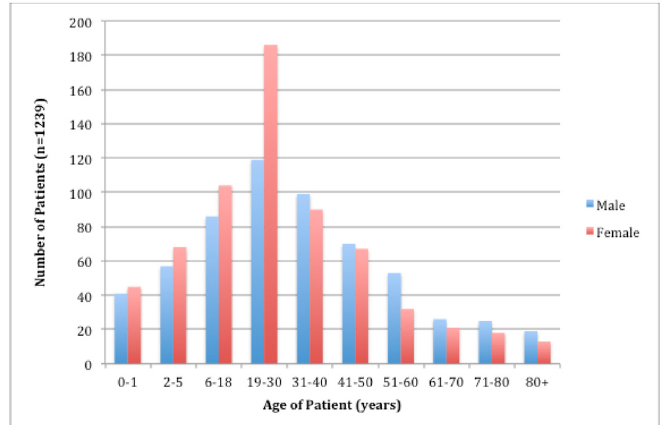
Figure 2. Age distribution of patients, by